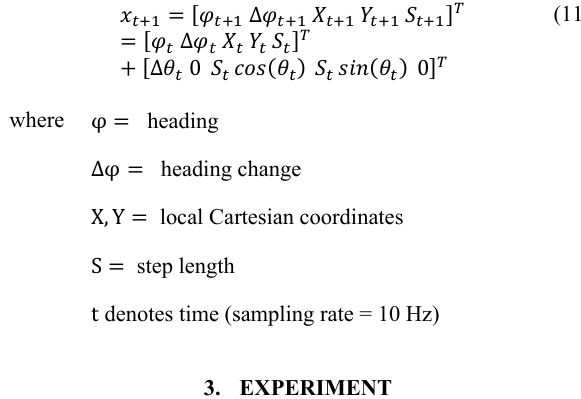
Figure 7. The illustration of PDR trajectory pattern